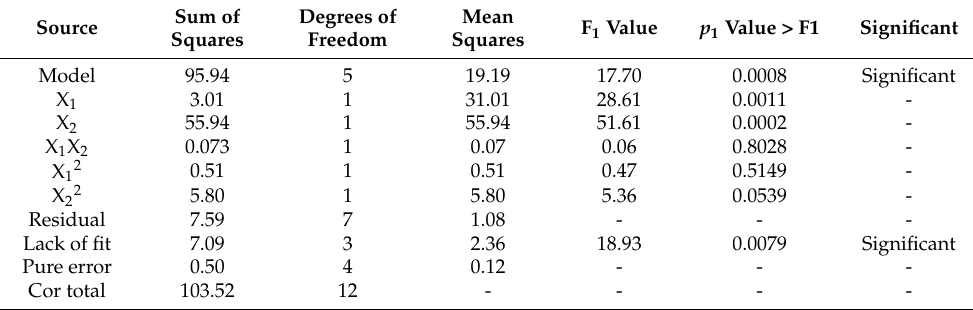
Table 5. Variance analysis results of the quadratic regression model of Y 1